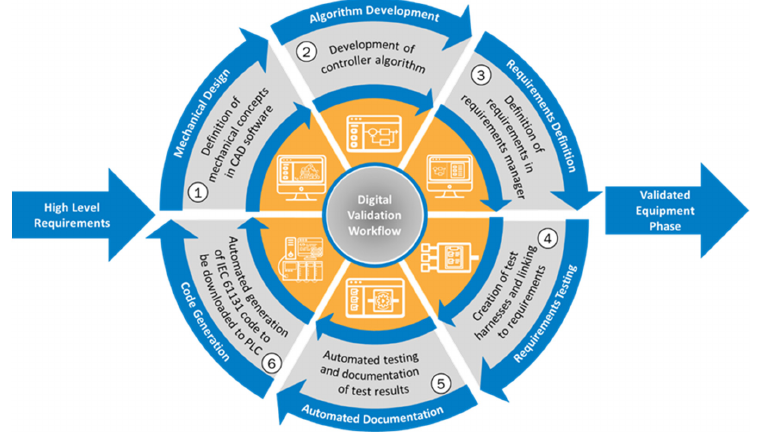
Figure 3. Proposed digital validation workflow for the creation of validated equipment phases.